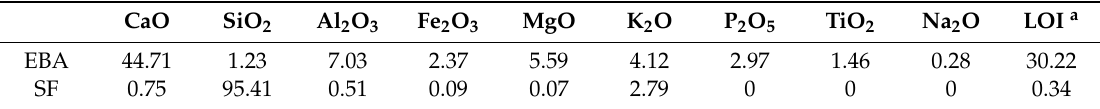
Table 1. Chemical composition of EBA and silica fume (SF).